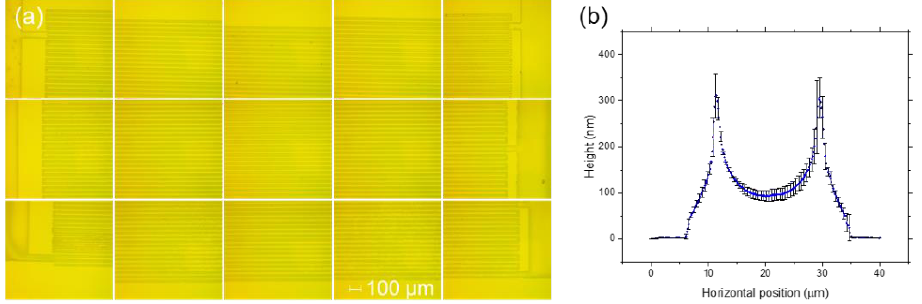
Figure 12. ( a ) Microscopic images and ( b ) height profiles of the PEDOT:PSS patterns made by add- ing both O 2 plasma treatments to traditional